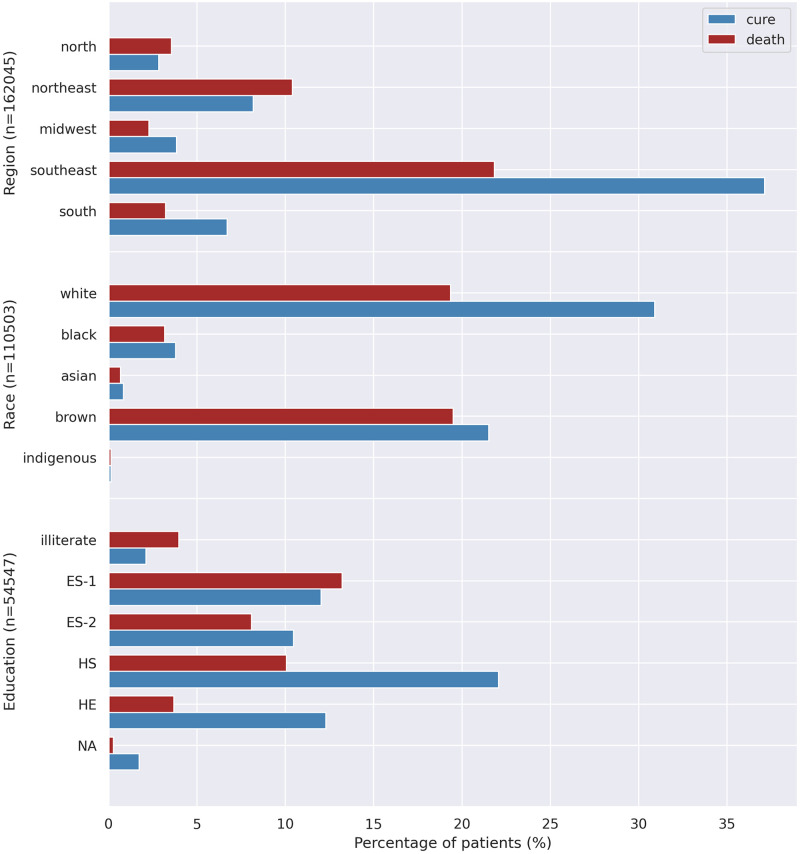
Outcome distribution according to demographic characteristics.Different number of patients apply (Brazilian regions: n = 162,045, race: n = 110,503, education: n = 54,547).